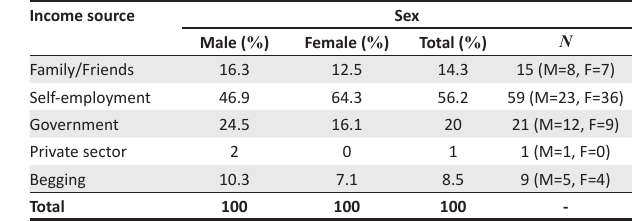
TABLE 6: Respondents monthly income by sex ( N = 105 Females 58 and Males 47).